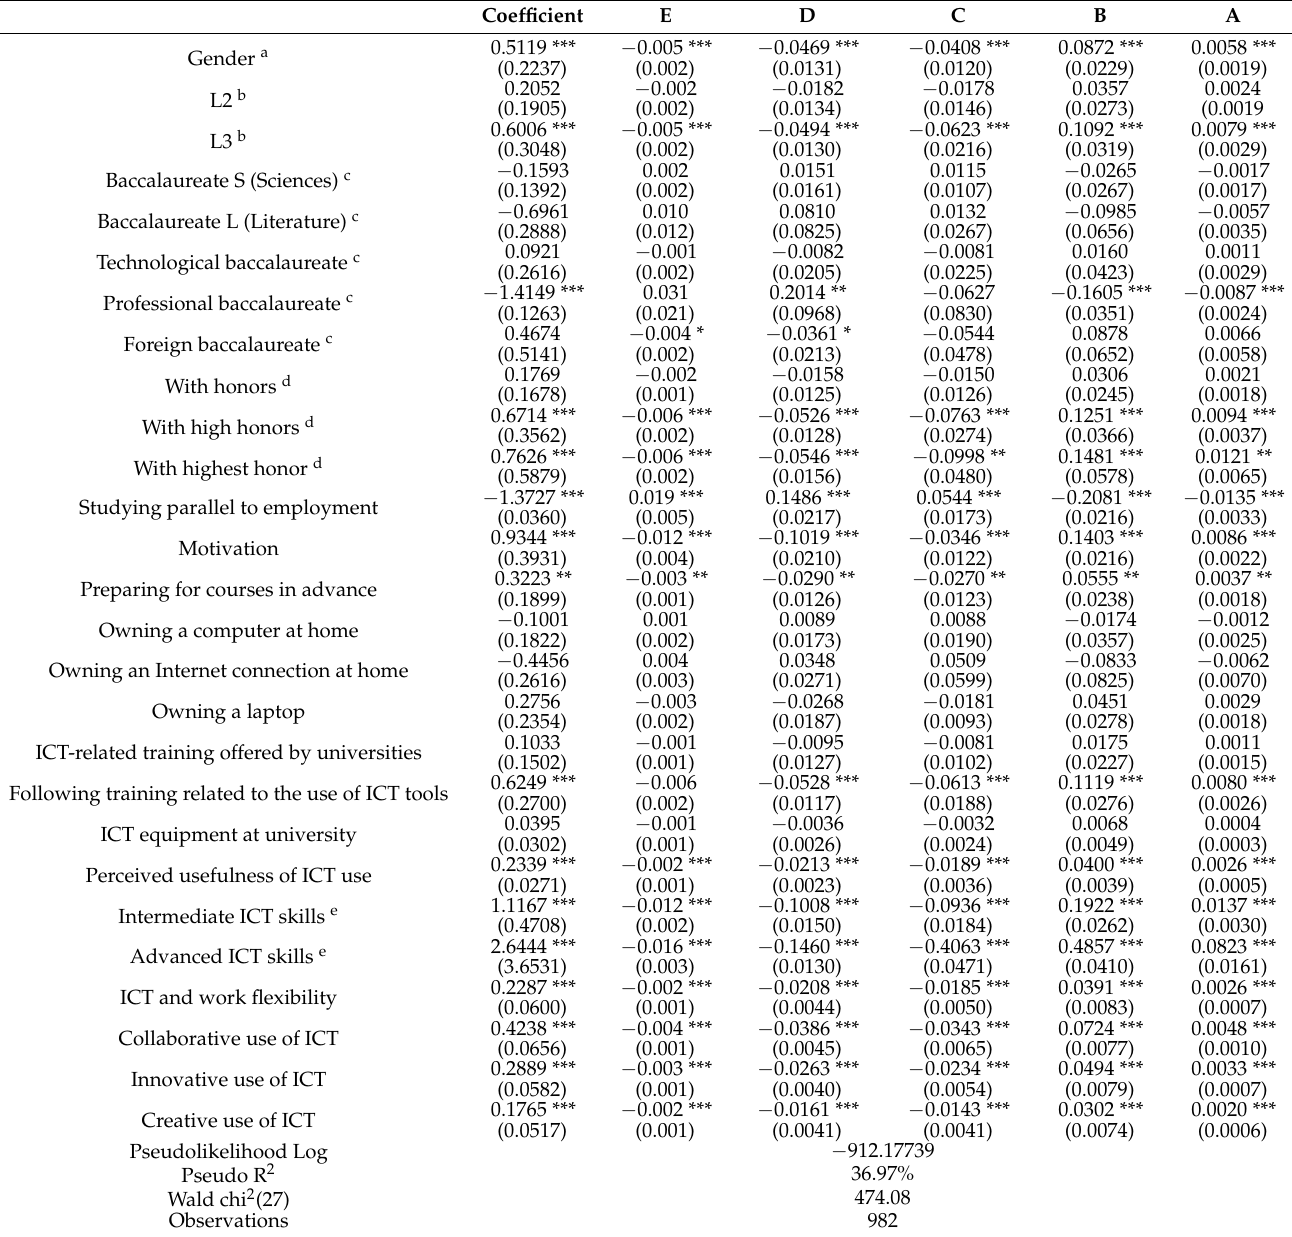
Table 6. Estimates of marginal effects—Model 1 f,g : Intensity of ICT use less than 6 h per